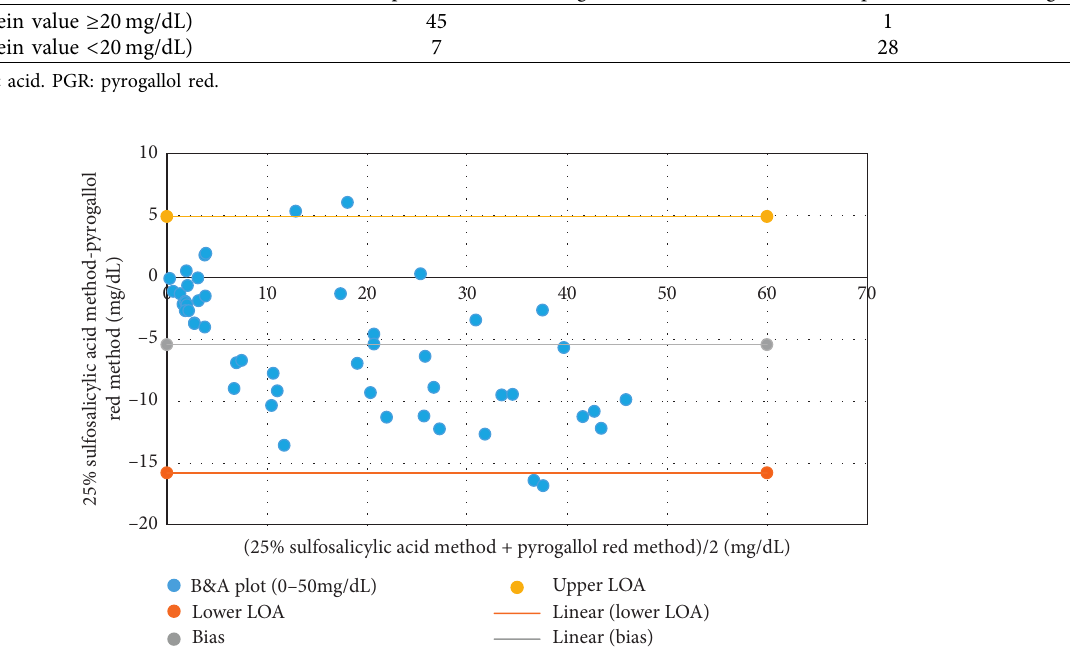
Figure 3: Bland–Altman plot of pyrogallol red method versus 25% sulfosalicylic acid method. B&A plot: Bland-Altman plot; lower LOA: lower limit of agreement; upper LOA: upper limit of agreement. Table 4: Precision check data of 25% sulfosalicylic acid method in phase II. No. of